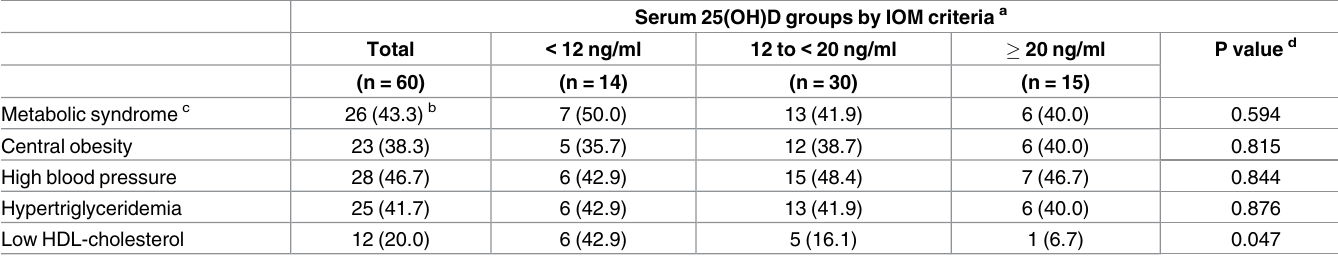
Serum 25(OH)D groups by IOM criteria a